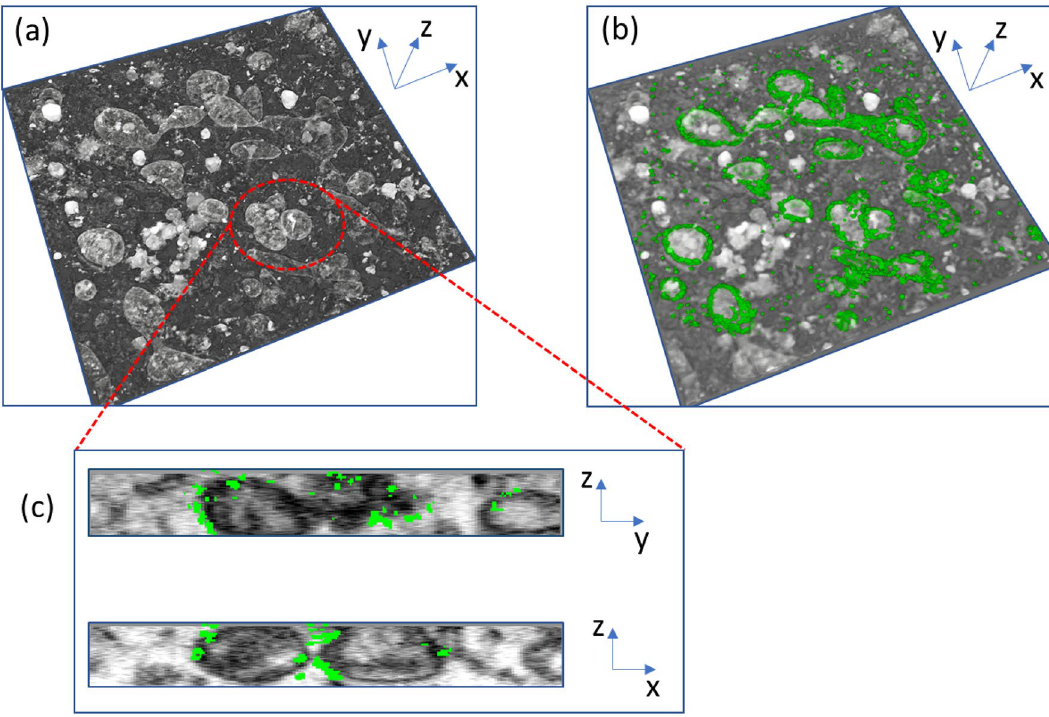
Figure 9. Full 3D CLEM dataset showing 3D volume renderings of OSSM SEM data ( a ) and with 3D iPALM rendering overlaid ( b ). OSSM SEM reconstruction and overlaid iPALM data of targeted mitochondria in YZ and XZ space ( c ). TOMM20 fluorescent markers are found only at the outer membrane of the mitochondrial structures as